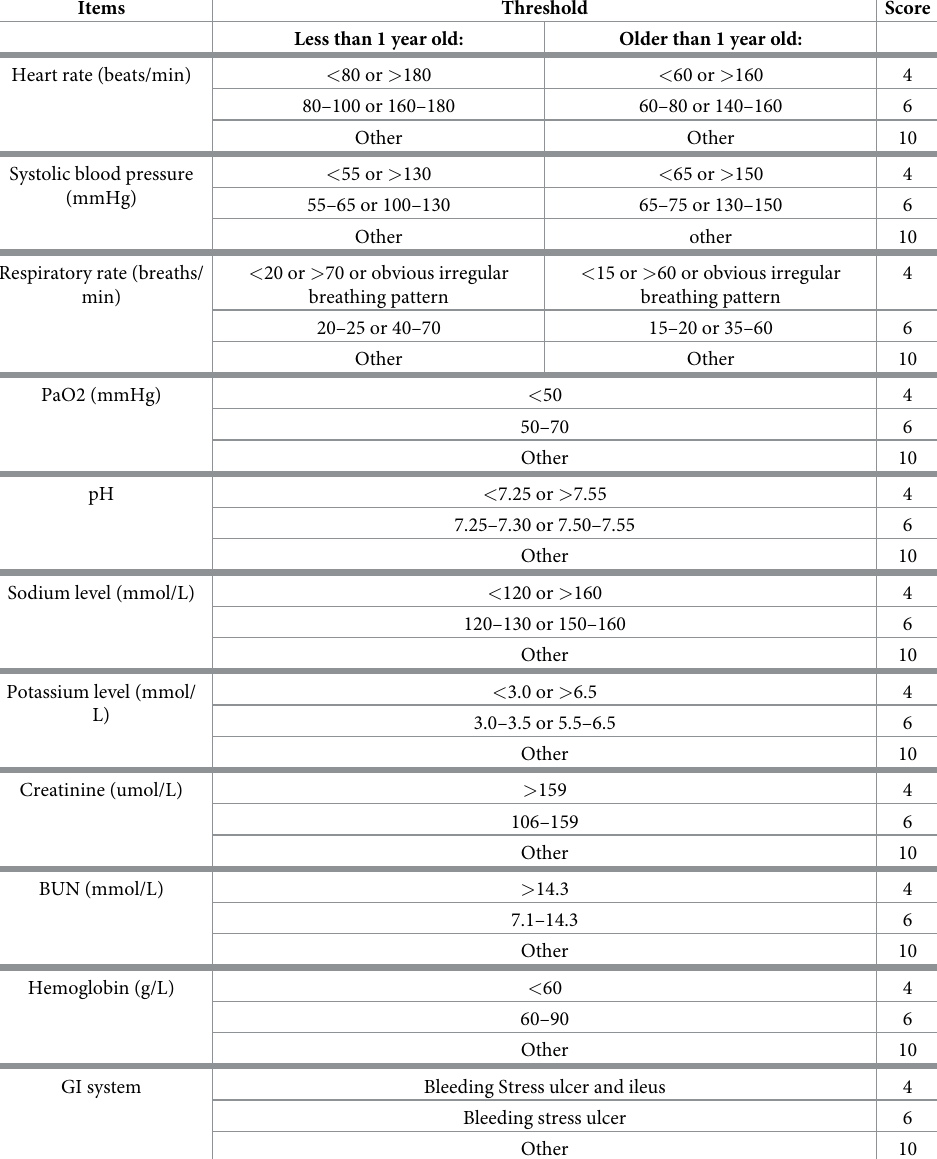
Table 1. PCIS criteria and scoring system